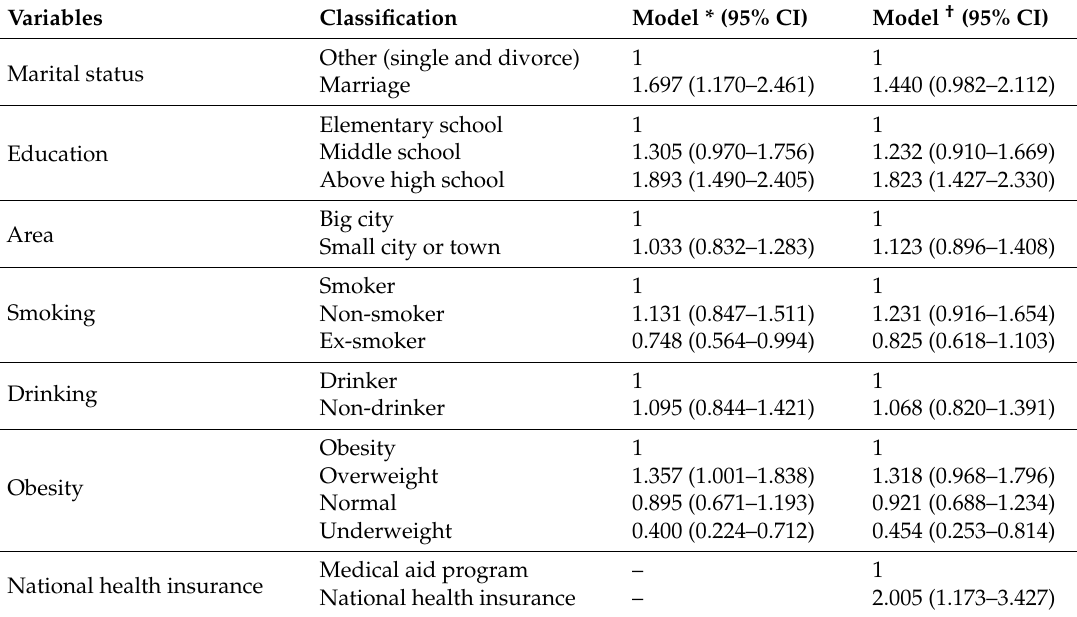
Table 3. Subjective health status of males aged 65 years and